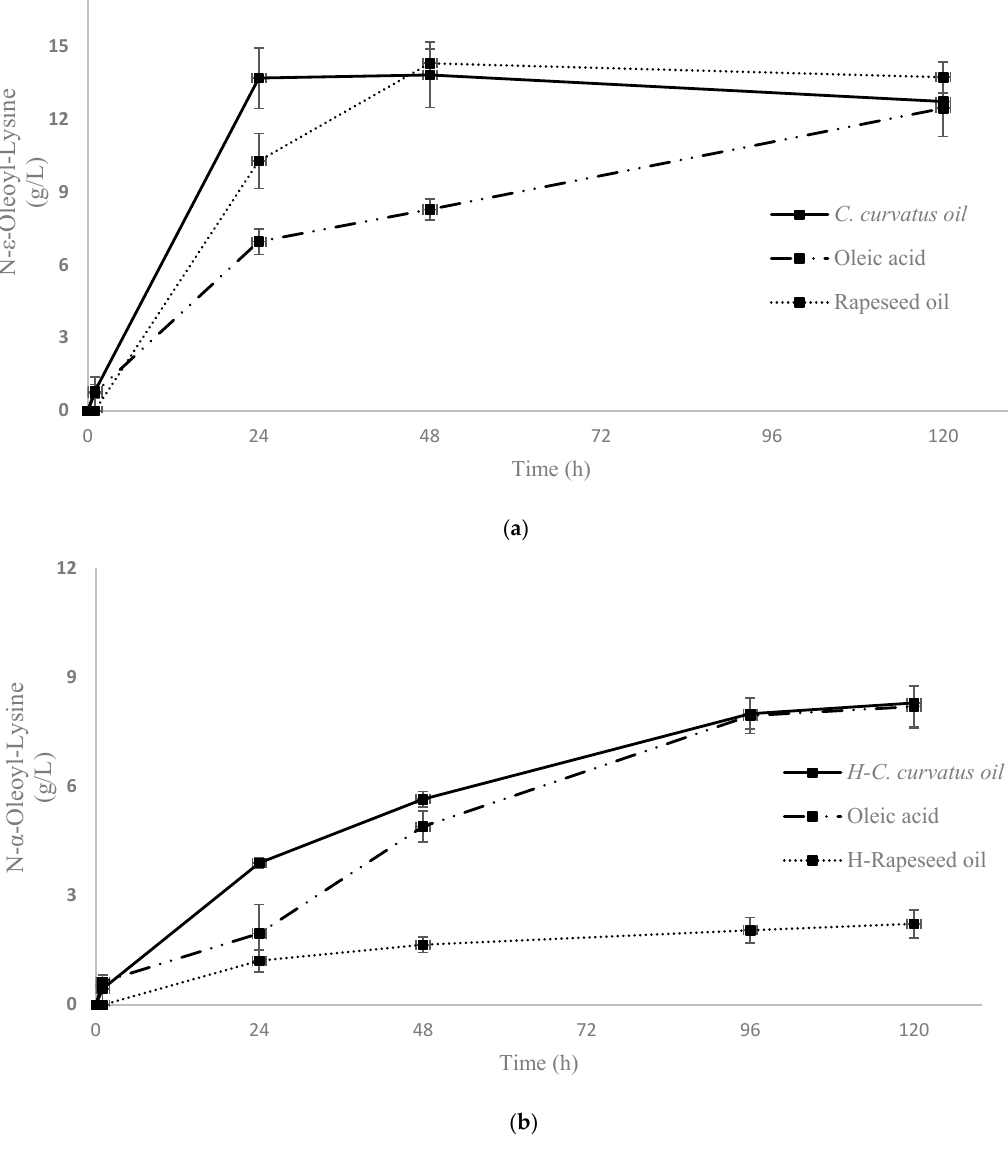
Figure 2. Kinetics of enzymatic synthesis of ε and α oleoyl-lysine by CALB ( a ) and aminoacylases ( b ), respectively, in different fatty acid mixtures and oils. Two replicates are presented in both diagrams.